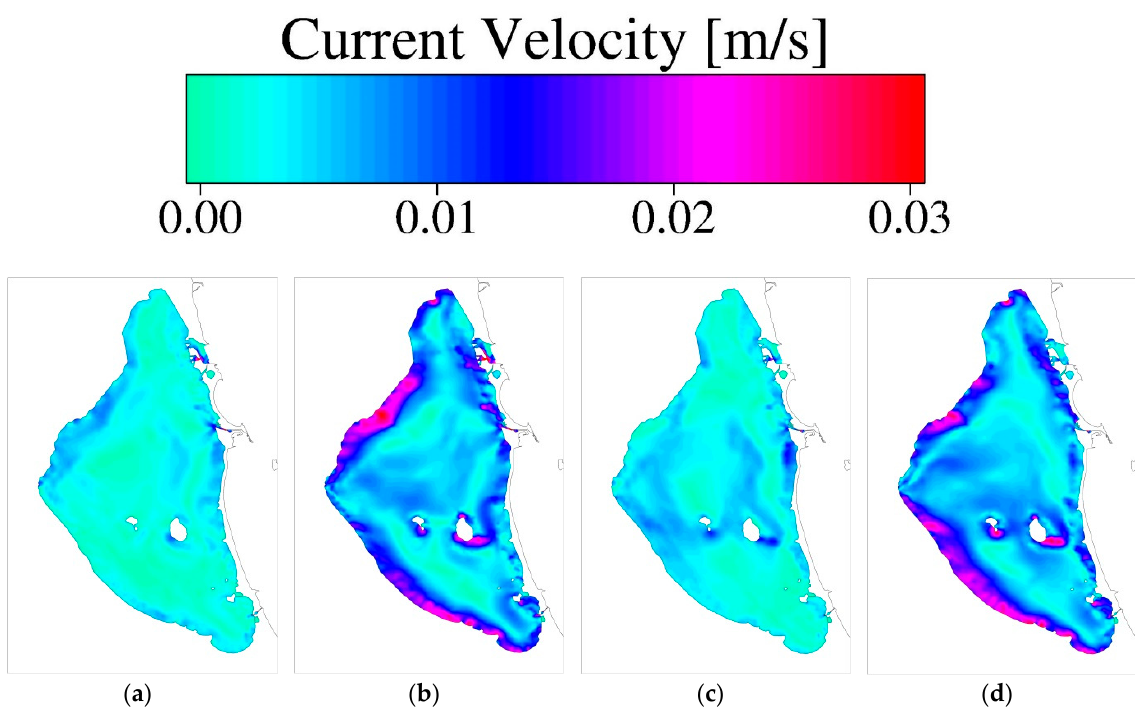
Figure 8. Seasonal average velocities.